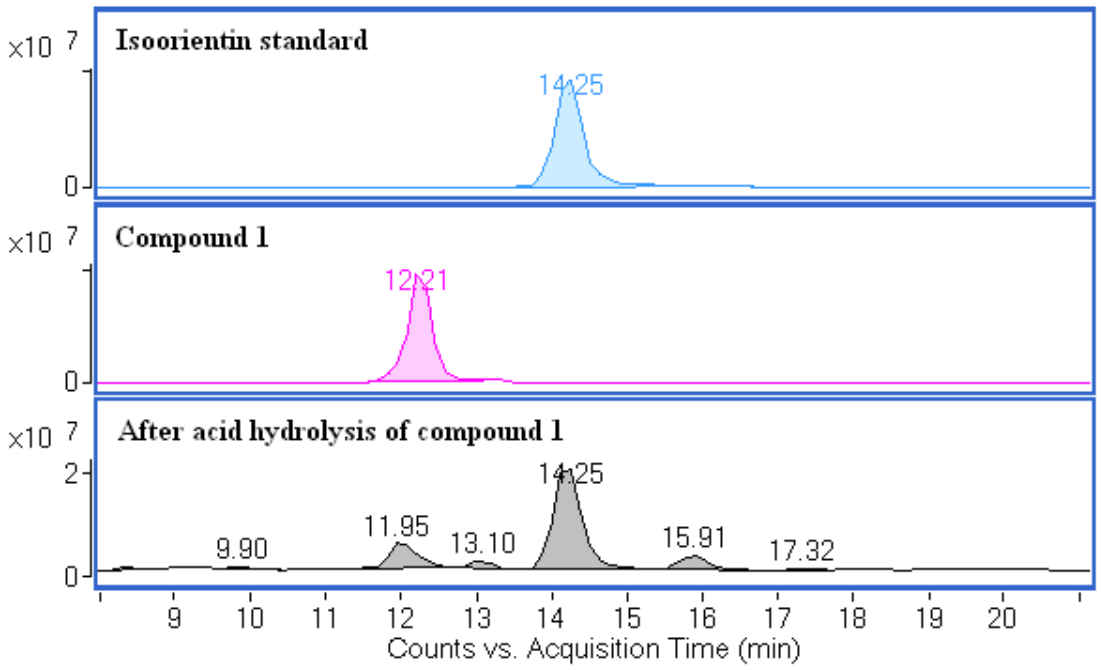
Figure 8. (+)ESI-Q-TOF-MS total ion chromatograms (TIC) of an isoorientin standard, compound 1 , and degradation products of compound 1 after acid